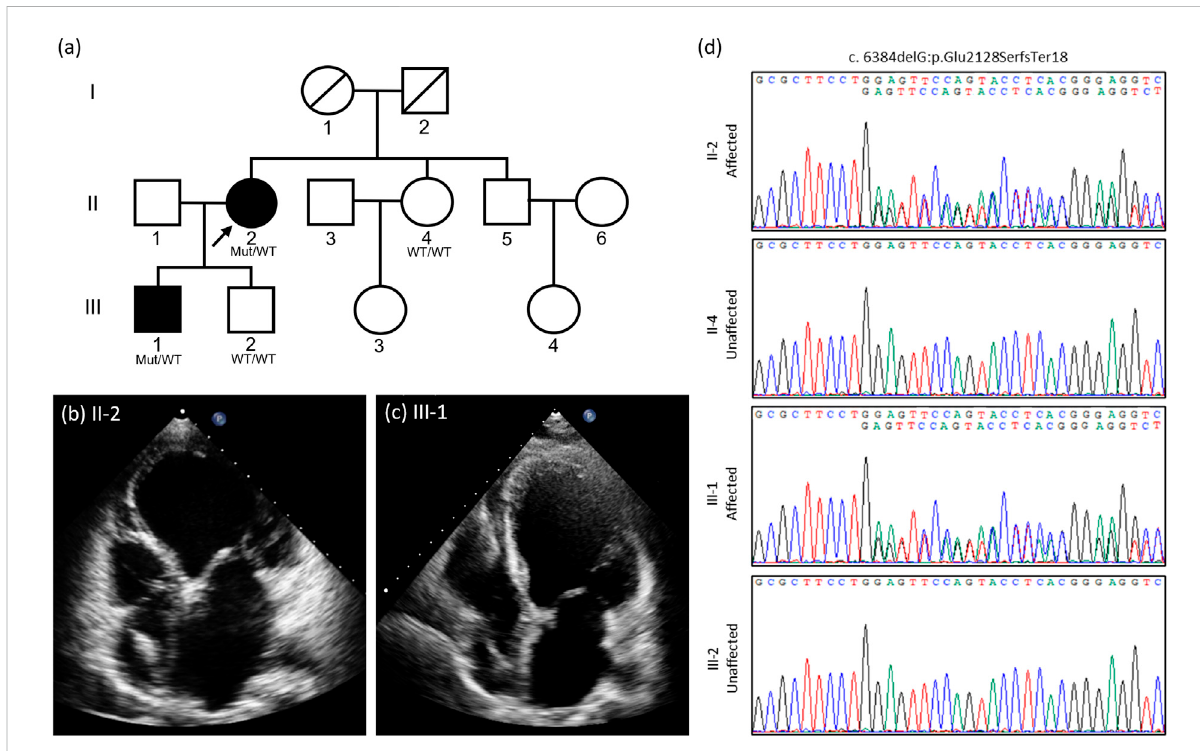
FIGURE 1 The pedigree and cardiac examinations of the proband (II-2) and her son (III-1). (A) The pedigree of the proband (arrow) and her family. (B) Echocardiography of the proband (II-2) shows dilated LV and LA with LVEDD 78 mm and poor LV function, with EF 32% and ICD lead in situ . (C) Echocardiography of the proband ’ s son (III-1) shows dilated LV and LA with LVEDD 78 mm and poor LV function with EF 22.8%, with the ICD lead in situ . (D) Geneticstudyoftheproband ’